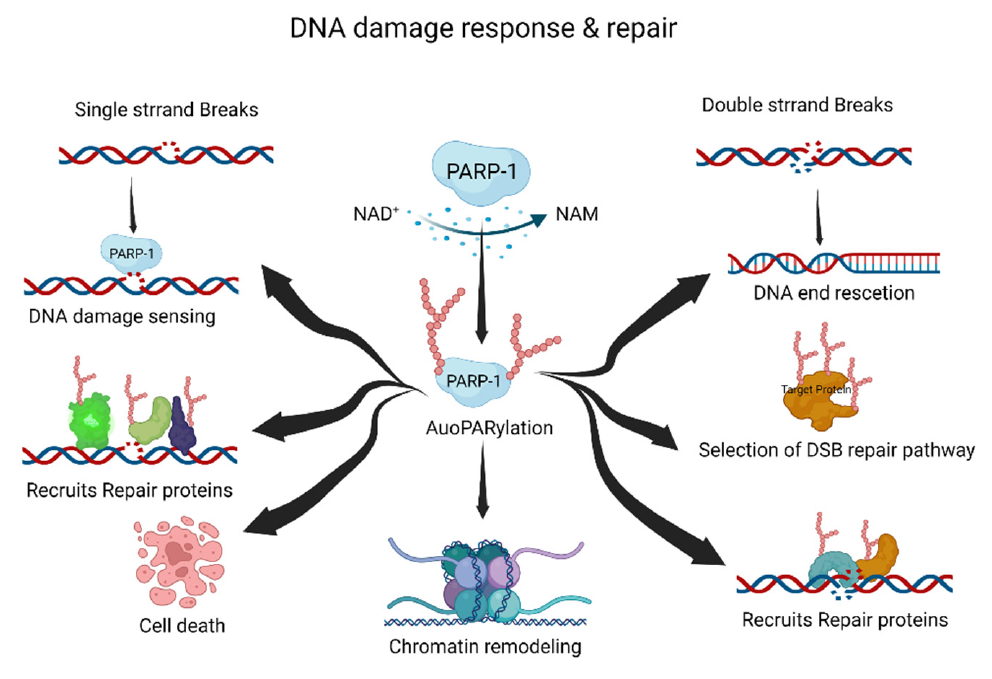
Figure 1. The roles of PARylation in DNA damage response and repair. PARylation acts as an initiator and/or selection effector of the DNA damage response and repair processes. NAD + , nicotinamide adenine dinucleotide; NAM, nicotinamide. This figure was created using BioRender. Typically, PARylation is induced by cellular stress and DNA damage [24,25]. When DNA damage occurs, the DDR recruits PARP-1 to the DNA damage site. Recruited